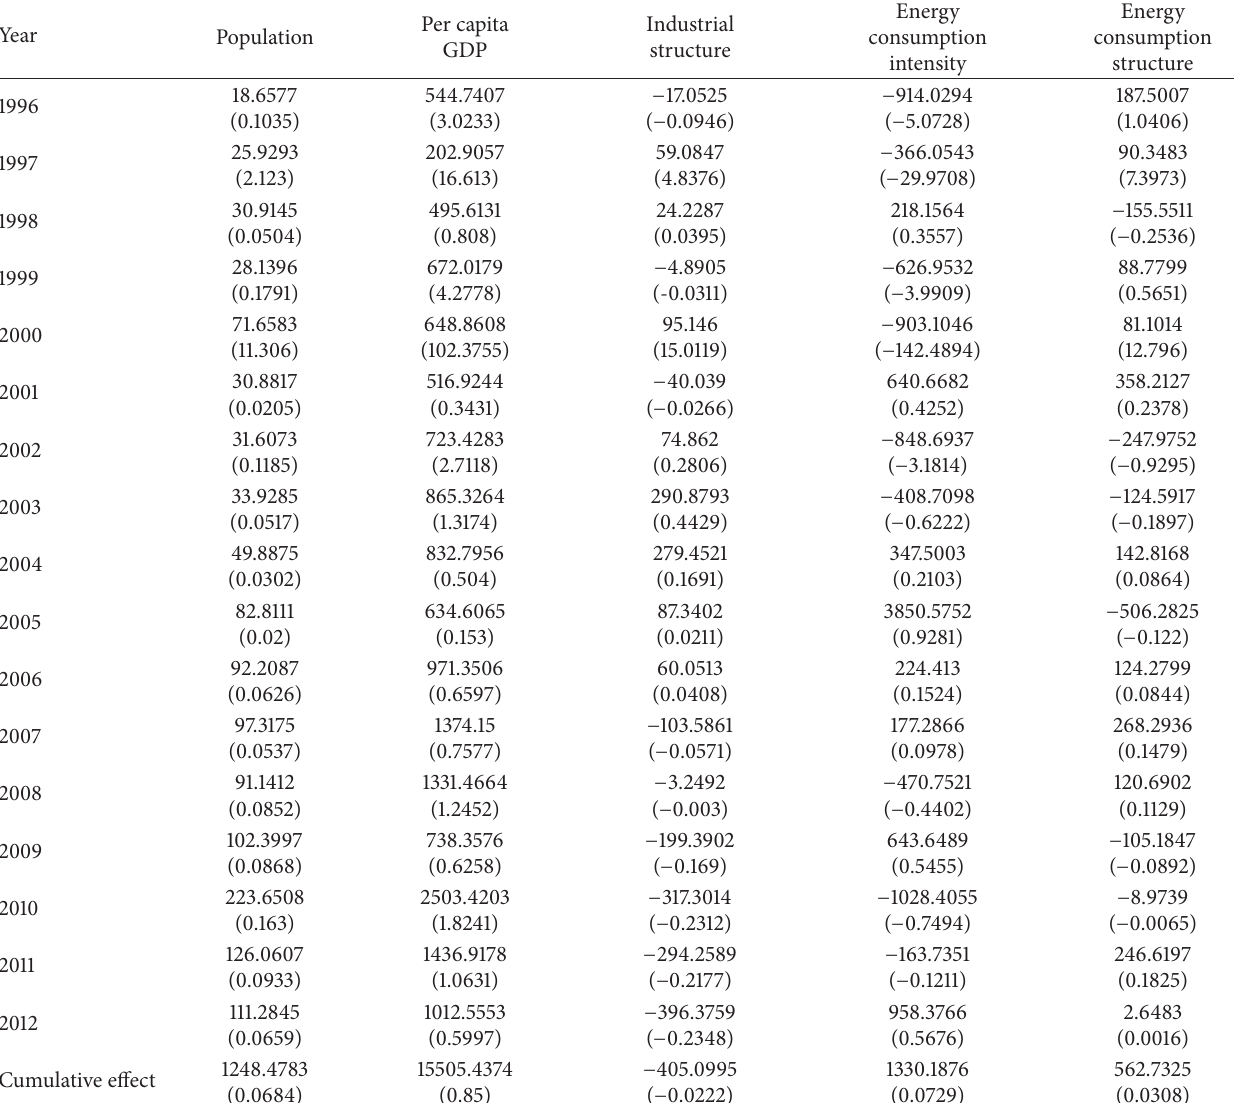
Table 3: Effects of different factors of carbon emissions from energy consumption of Shandong province from 1996 to 2012 by Shapley value